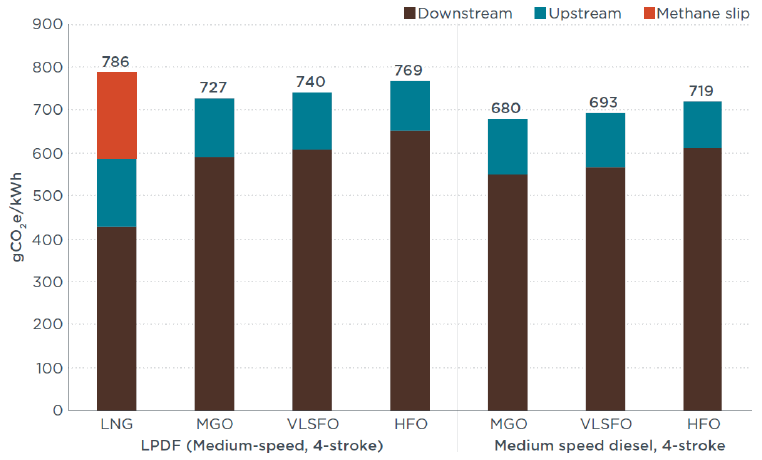
Figure 15. GHG emissions for cruise ship engines, 100-year GWP. Reprinted from ref. [58].